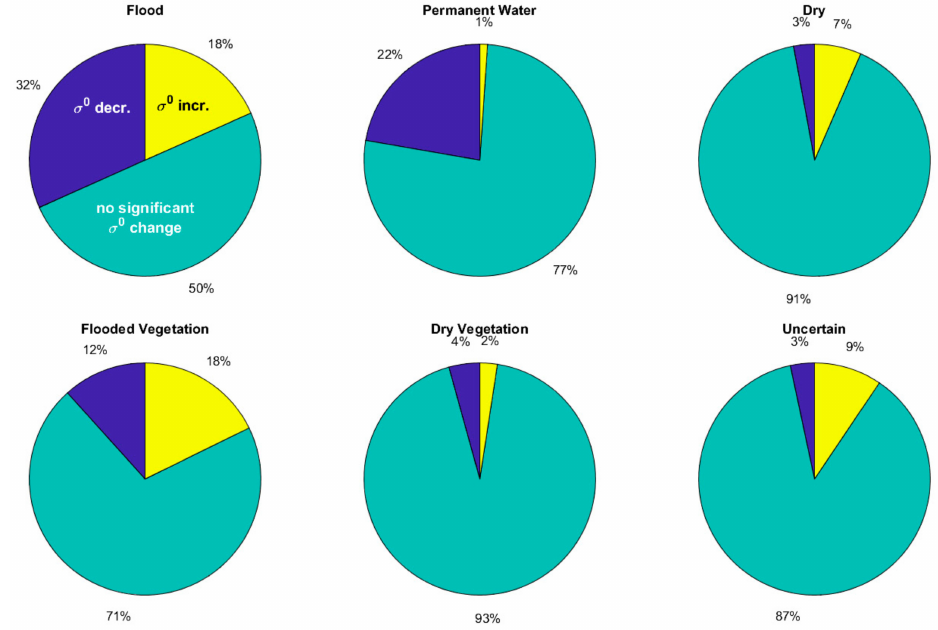
Figure 10. Pie charts showing, for each of the 6 classes, the proportions of pixels detected as flooded with either σ 0 decrease (blue) or σ 0 increase (yellow), or as nonflooded with insignificant σ 0 change at the p50